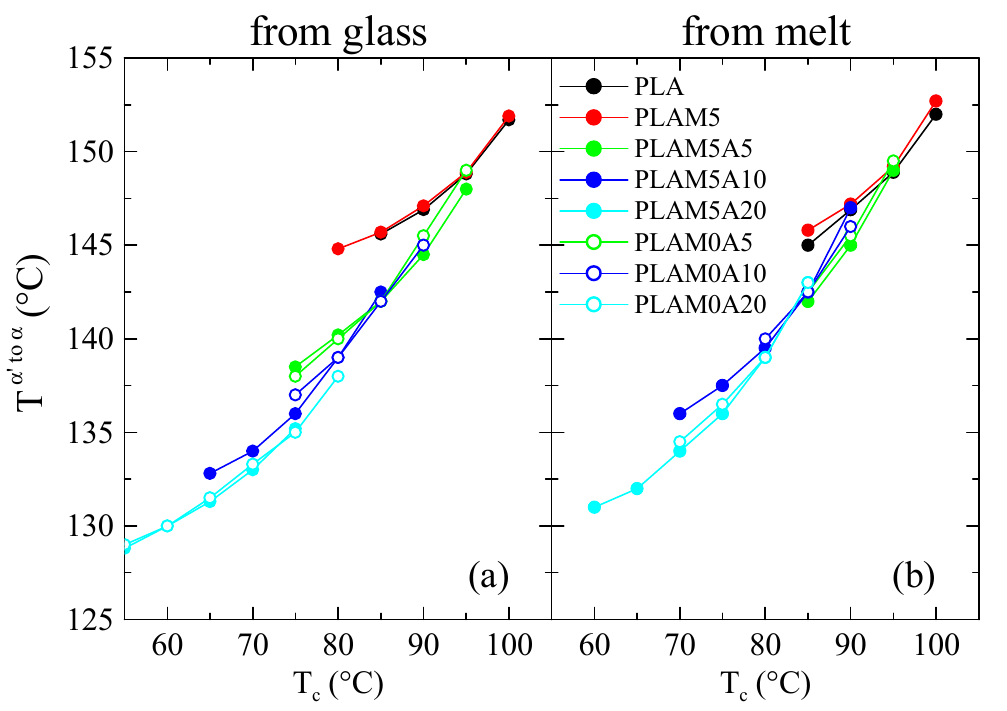
Figure 11. Variation with T c of the temperature for transition from the α ’ to α for the different samples, when crystallizing ( a ) from the glass, and ( b ) from the melt.